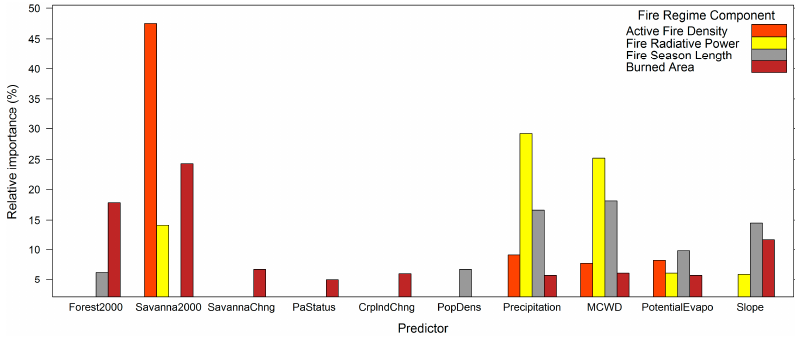
Figure 8. Relative influences of the top 10 predictors from the BRT models of fire regime components. Only variables with relative importance values ≥ 5% of the variation are plotted here. Abbreviations of predictor variables and their descriptions are provided in Table 1.